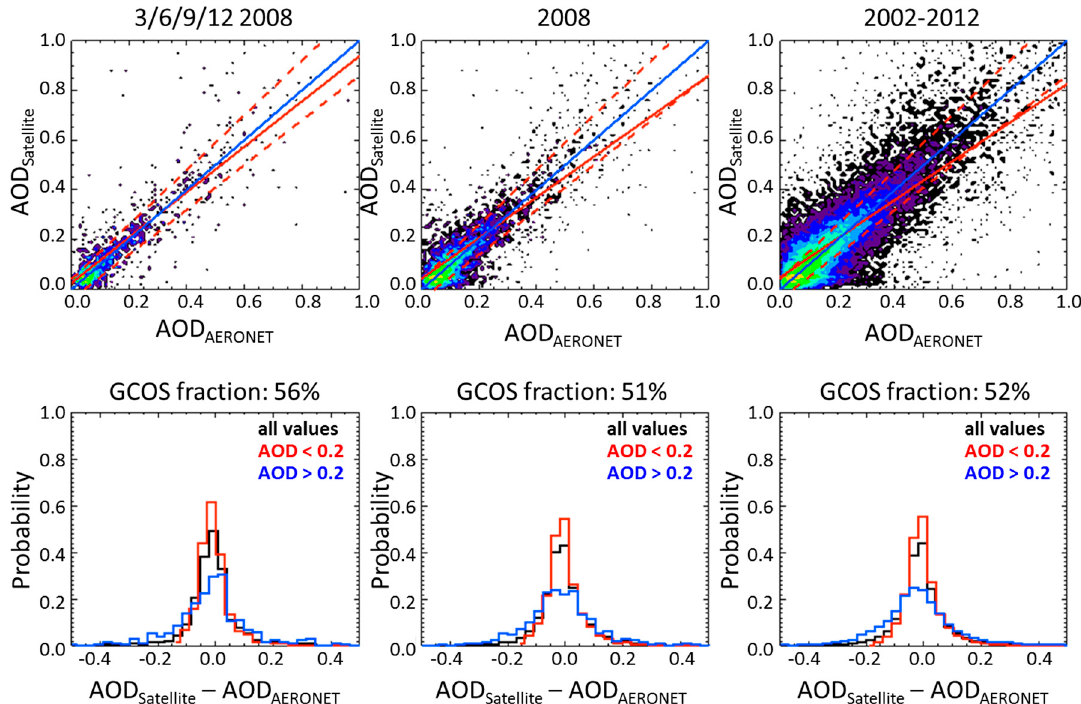
Figure 2. Validation of AATSR SU (Swansea University) retrieved AOD version 4.21 (L2—level 2) over land vs. AERONET AOD at 550 nm for four months of 2008 (panels on the ( left ) hand side); for the whole year 2008 (( middle ) panels) and for the years 2002–2012 (panels on the ( right ) hand side). Upper panels show AOD scatter plots, lower panels contain probability histograms of the difference between satellite and AERONET AODs. In upper panels the solid line shows a linear regression fit and the dashed lines indicate the Global Climate Observing System (GCOS) envelope. Table 4. Validation of AATSR SU retrieved AOD (L2) v4.21 vs. AERONET AOD for different data